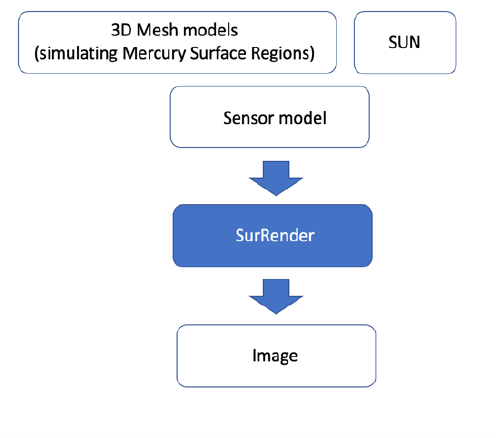
Figure 3. SurRender software